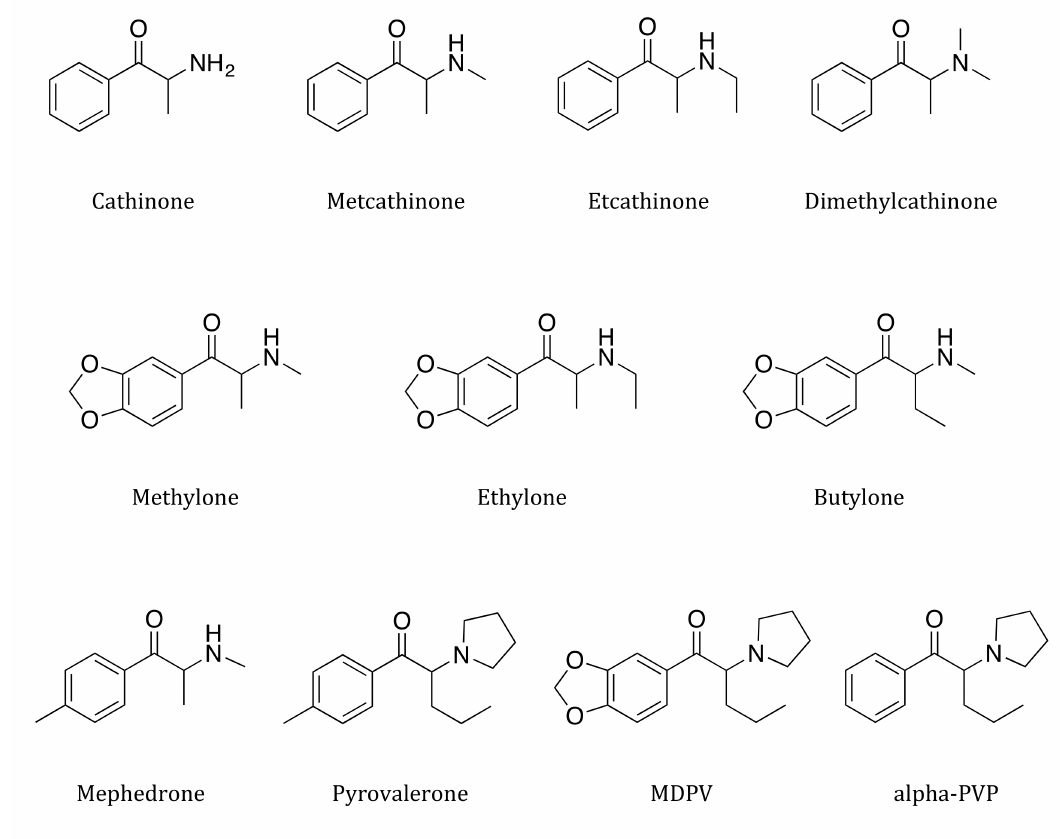
Figure 1. Chemical structures of some important synthetic